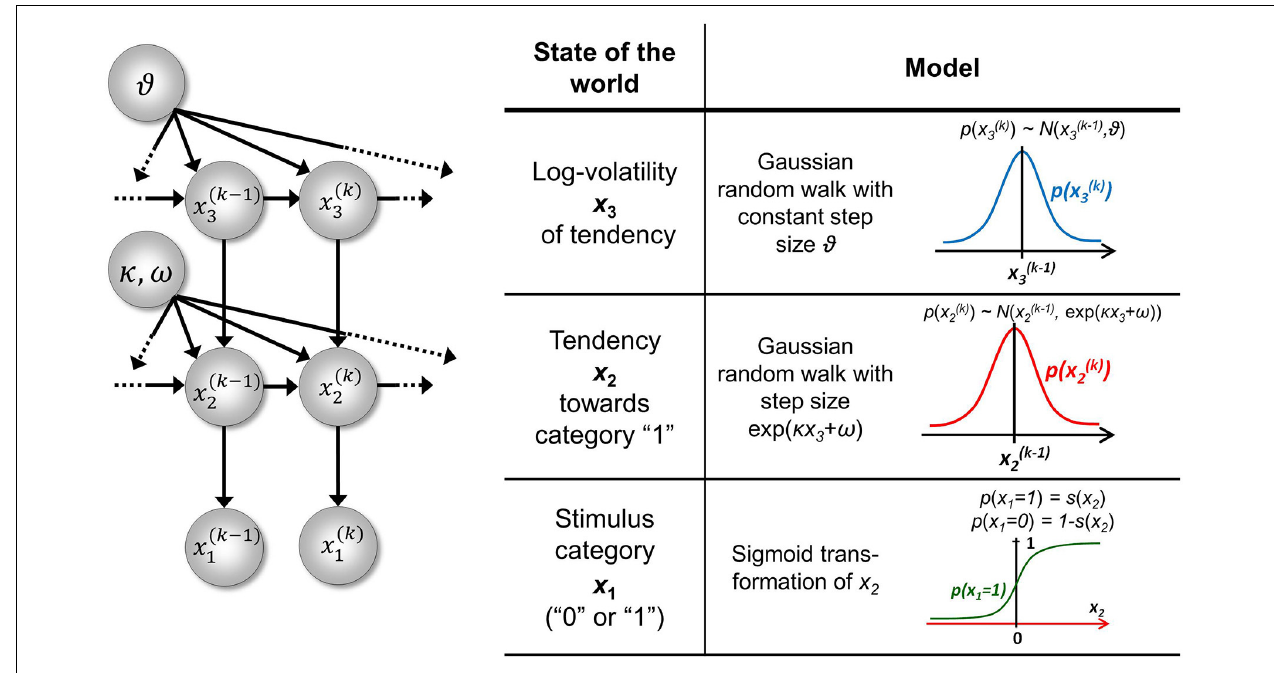
FIGURE 2 | The 3-level HGF for binary outcomes. The lowest level, x 1 , is binary and corresponds, in the absence of sensory noise, to sensory input u . Left: schematic representation of the generative model as a Bayesian network. x ( k ) 1 , x ( k ) 2 , x ( k ) 3 are hidden states of the environment at time point k .